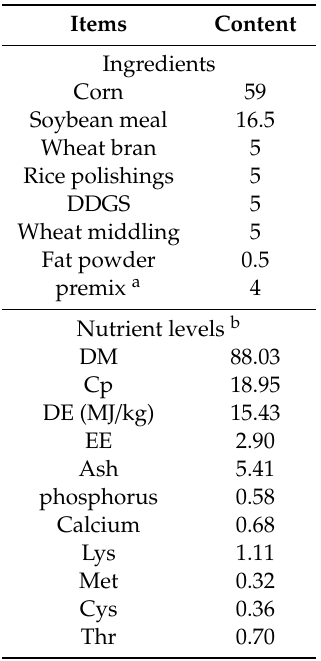
Table 1. Composition and nutrient levels of the basal diet (dry matter basis).